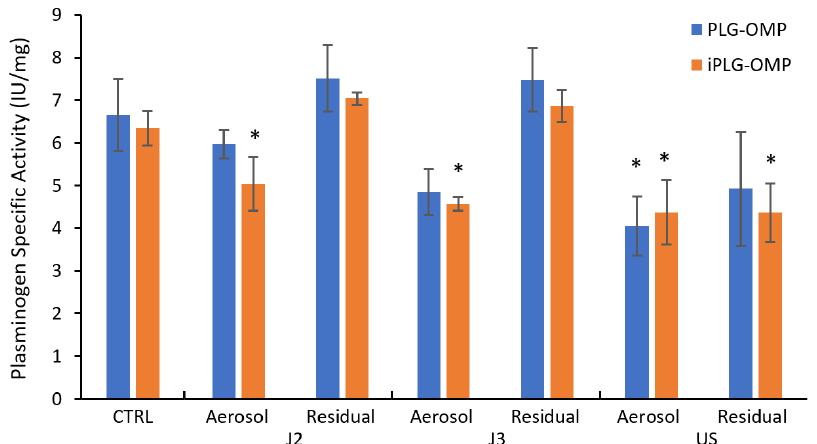
Figure 2. Jet (J2 and J3) and ultrasonic (US) nebulization of PLG-OMP and iPLG-OMP solutions. Specific activity of plasminogen was determined in the aerosol and residual solutions, which were collected from the ampoules at the end of nebulisation. The data were statistically analyzed using Student’s t-test. Statistical significance was set at the level of * p < 0.01.